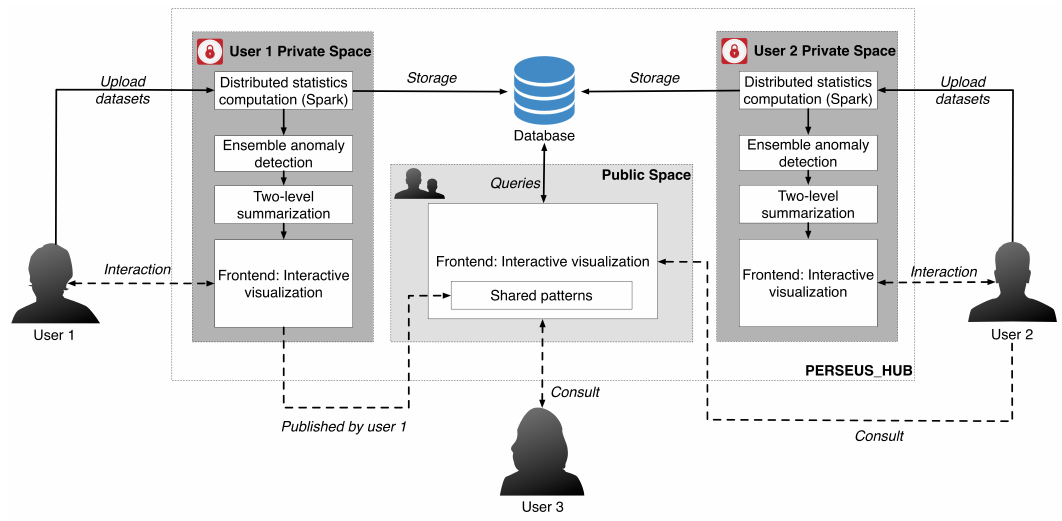
Figure 1. Overview of P ERSEUS -H UB . The solid arrows indicate the system behaviors and the dashed arrows indicate the user behaviors. In this example, User 1 uploads the dataset to analyze to the private working space, and publishes it with marked patterns that he thinks are worth exploration. Other users who are interested in the published graph (User 2 and User 3) may refer to the analysis by User 1 in the public working space, or perform analysis in their private working space (e.g., User 2).